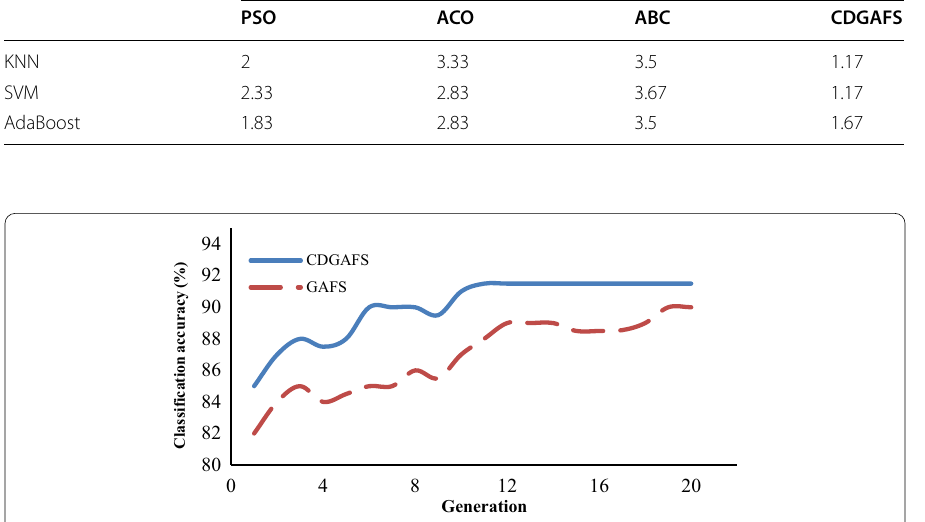
Fig. 7 Comparison of Convergence Process of Proposed Method Using Repair Operator. (CDGAFS) and Without Using Repair Operator (GAFS) on SpamBase dataset